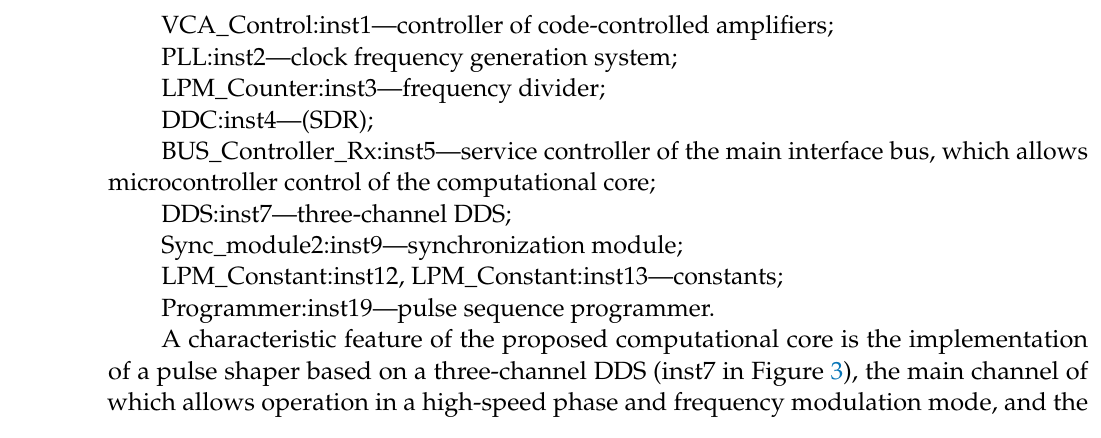
Figure 3. Configuration structure of an integrated computational core of pulsed NQR sensor based on FPGA.